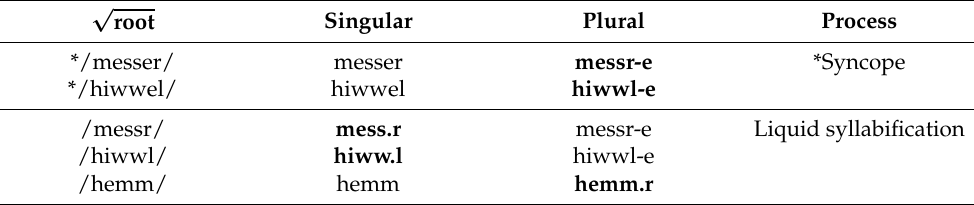
Table 2. Potential syllabification patterns in consonant-liquid coda clusters. √